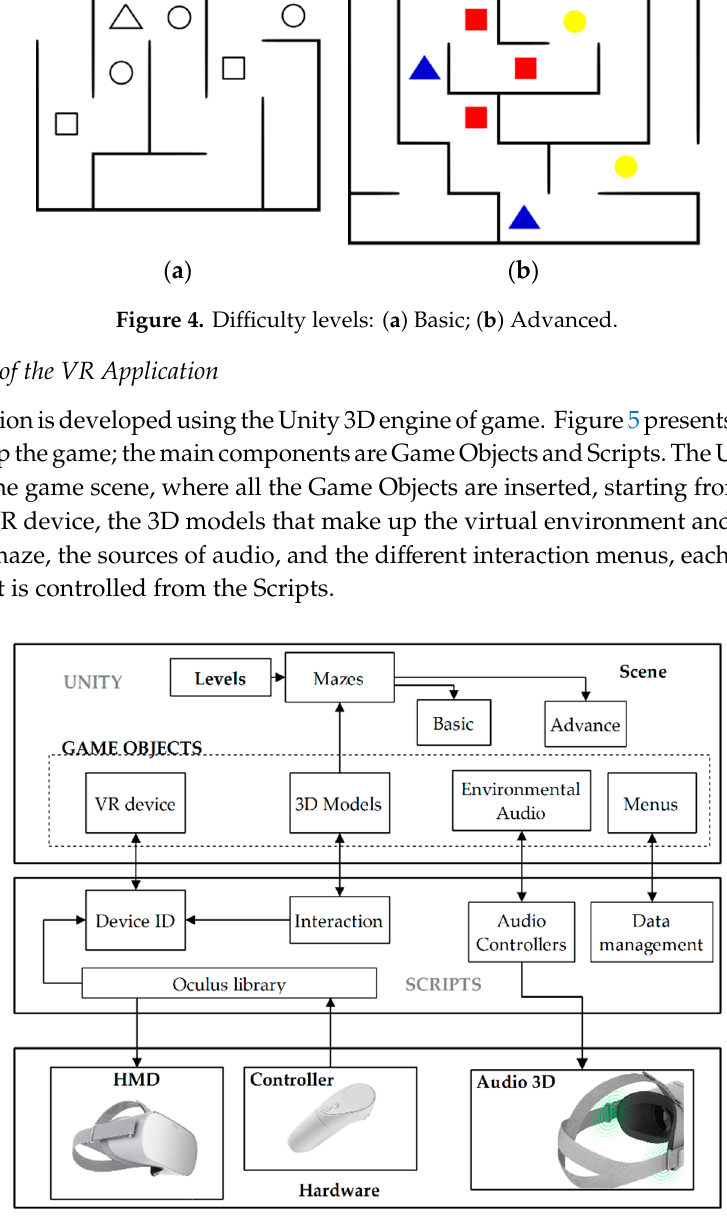
Figure 5. Diagram of the development of the immersive virtual reality application.